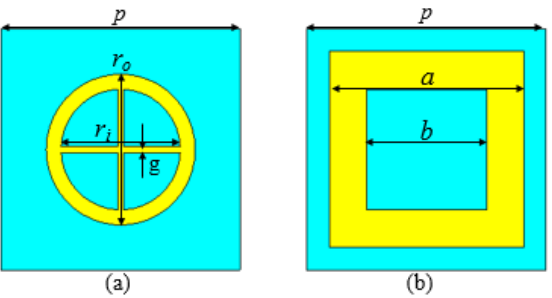
Figure 1. Structure of metasurface unit cells. ( a ) artificial magnetic conductor (AMC1) unit cell. ( b ) AMC2 unit cell.